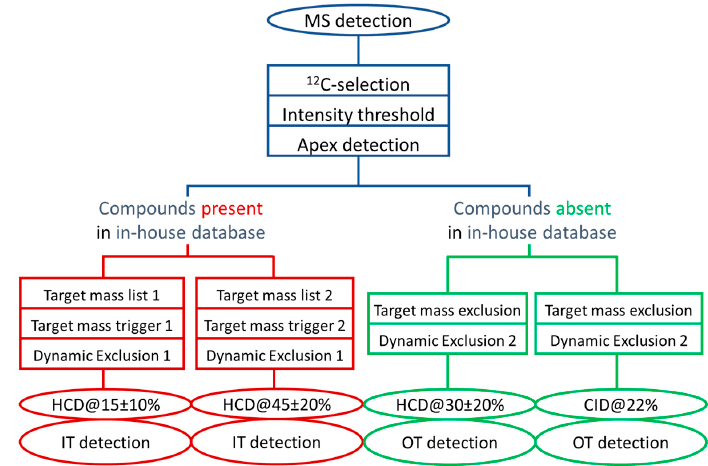
Figure 3. Schematic overview of the DDA method to collect meaningful MS/MS data for knowns and unknowns. See Table S3 for detailed information about the acquisition conditions. IT: Ion Trap, OT: Orbitrap.